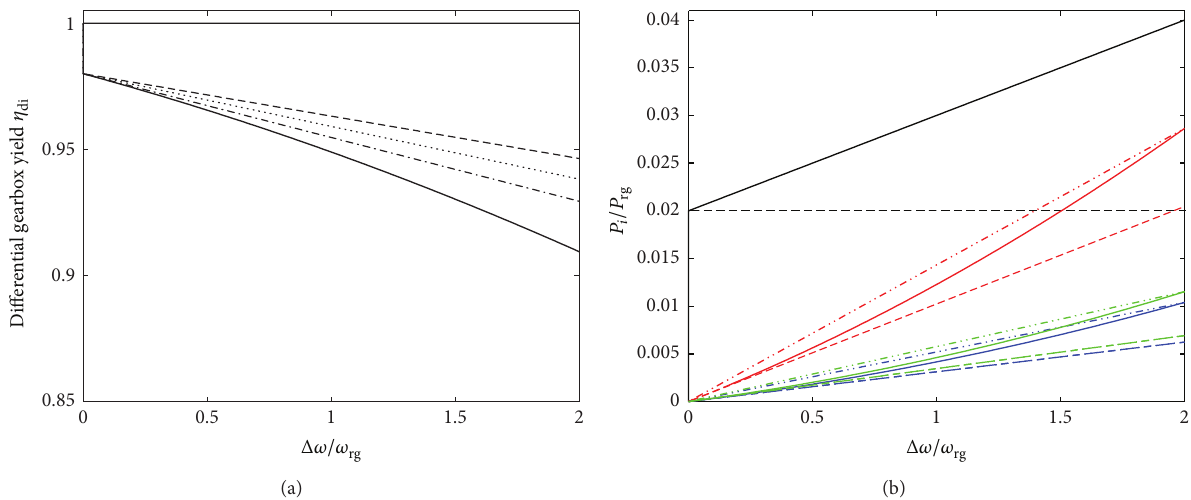
,𝜇 ) : forvarioussetsofcoefficientsoffriction (𝜇 rg ax / sa sh ,𝜇 ) , and 𝜂 undergoing ax / sa sh sa / pl ; the thick solid line gives the yield rg = 0 , ∀𝑖 . (b) Loss ratio ; that is, 𝑙 𝑖 = 𝑃 𝑖 /𝑃 rg rg and with the same sets of rg from 0.98 to 0.96 , 𝑙 sa / pl ax / sa